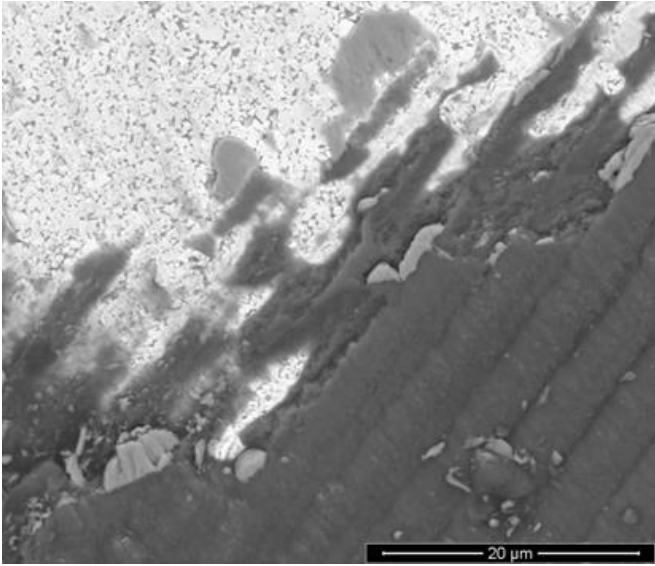
Figure 17. Adhesive wear detected on the T4 tool’s rake face, tested at 4-m cutting length and at 100% feed rate.